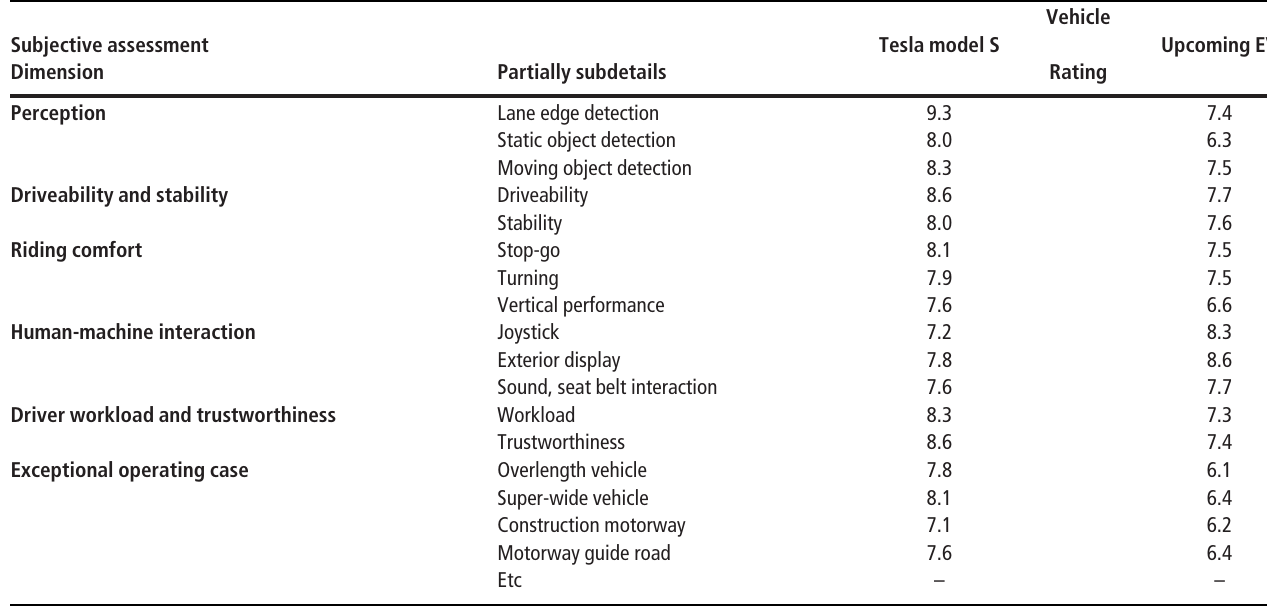
Table A2 Partially results of the subjective assessment with